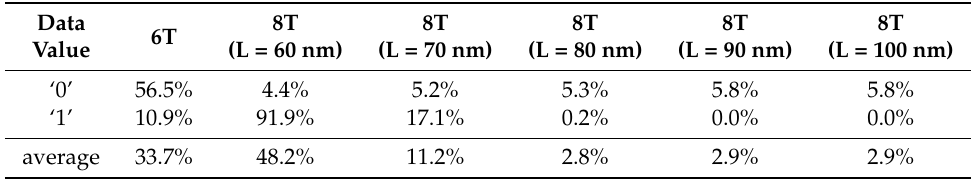
Figure 8. A bit-line voltage distribution in the Monte Carlo simulation of the reading operation. ( a ) 6T ( b ) 8T SRAM with different M4 channel lengths. Table 3. Read-error rate of 6T SRAM and 8T